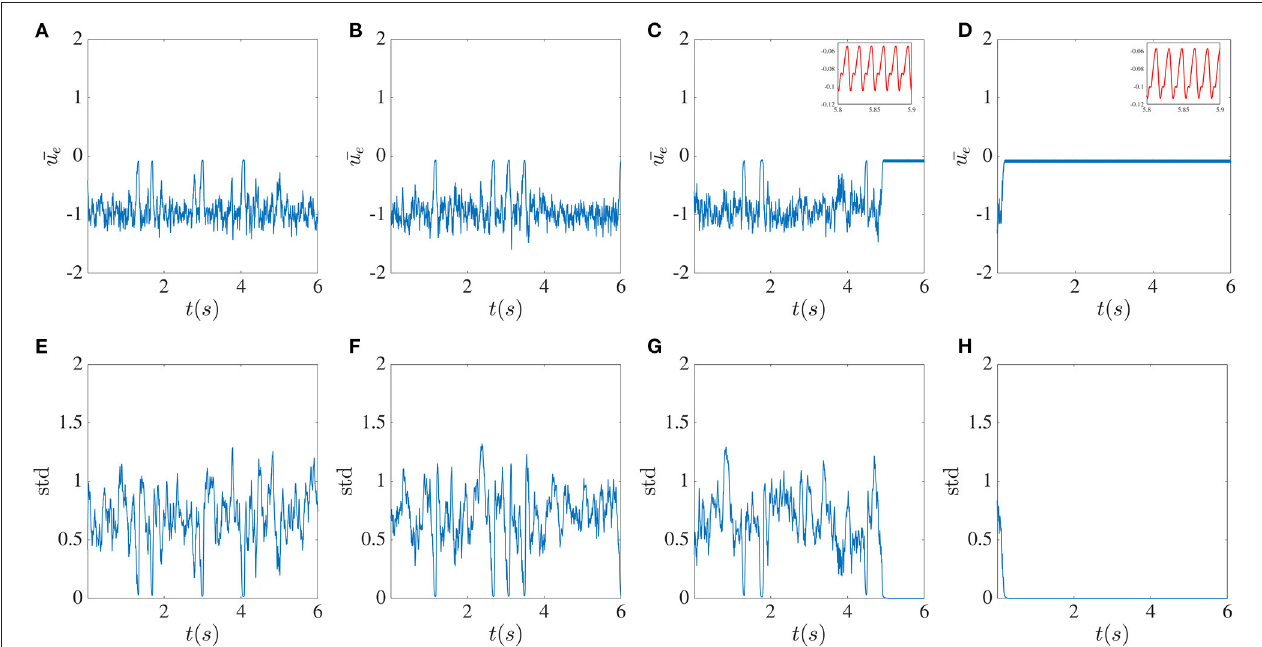
FIGURE 12 | Broadening the local delay distribution initiates complexity collapse in the presence of global delayed feedback. Mean excitatory sub-network activity for different numbers M of local delays. From top to bottom, M 6 (A,E) , 11 (B,F) , 16 (C,G) , and 21 (D,H) . The global feedback time delay T is 10 ms and the feedback = strength κ